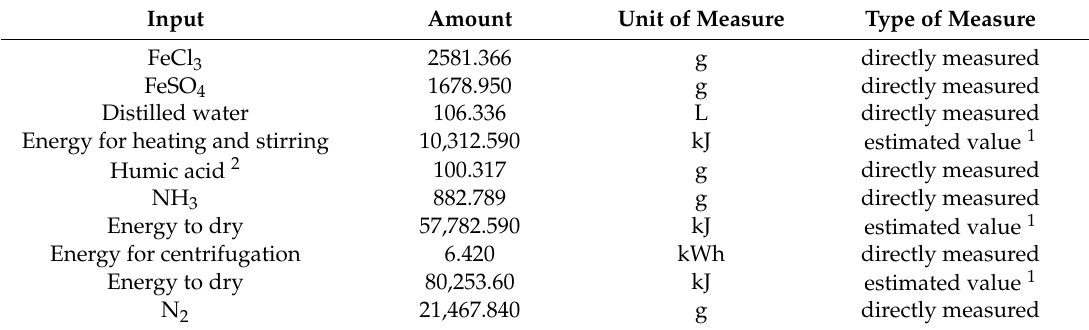
Table 10. Inventory for the synthesis of 1 kg of magnetite particles (Fe 3 O 4 / HA), according to [8,22].